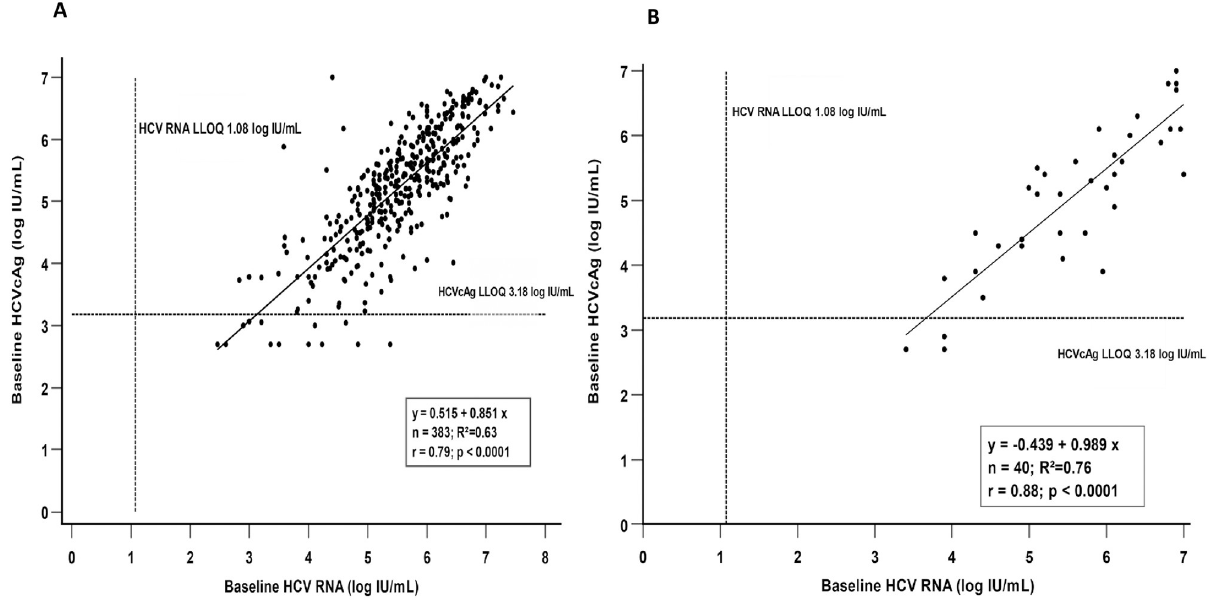
Fig 4. Baseline correlation between HCV RNA and HCVcAg. (A) Treatment-na ï ve. (B) Previously treated. Abbreviations: HCV, hepatitis C virus; RNA, ribonucleic acid; HCVcAg, hepatitis C virus core antigen; LLOQ, lower limit of